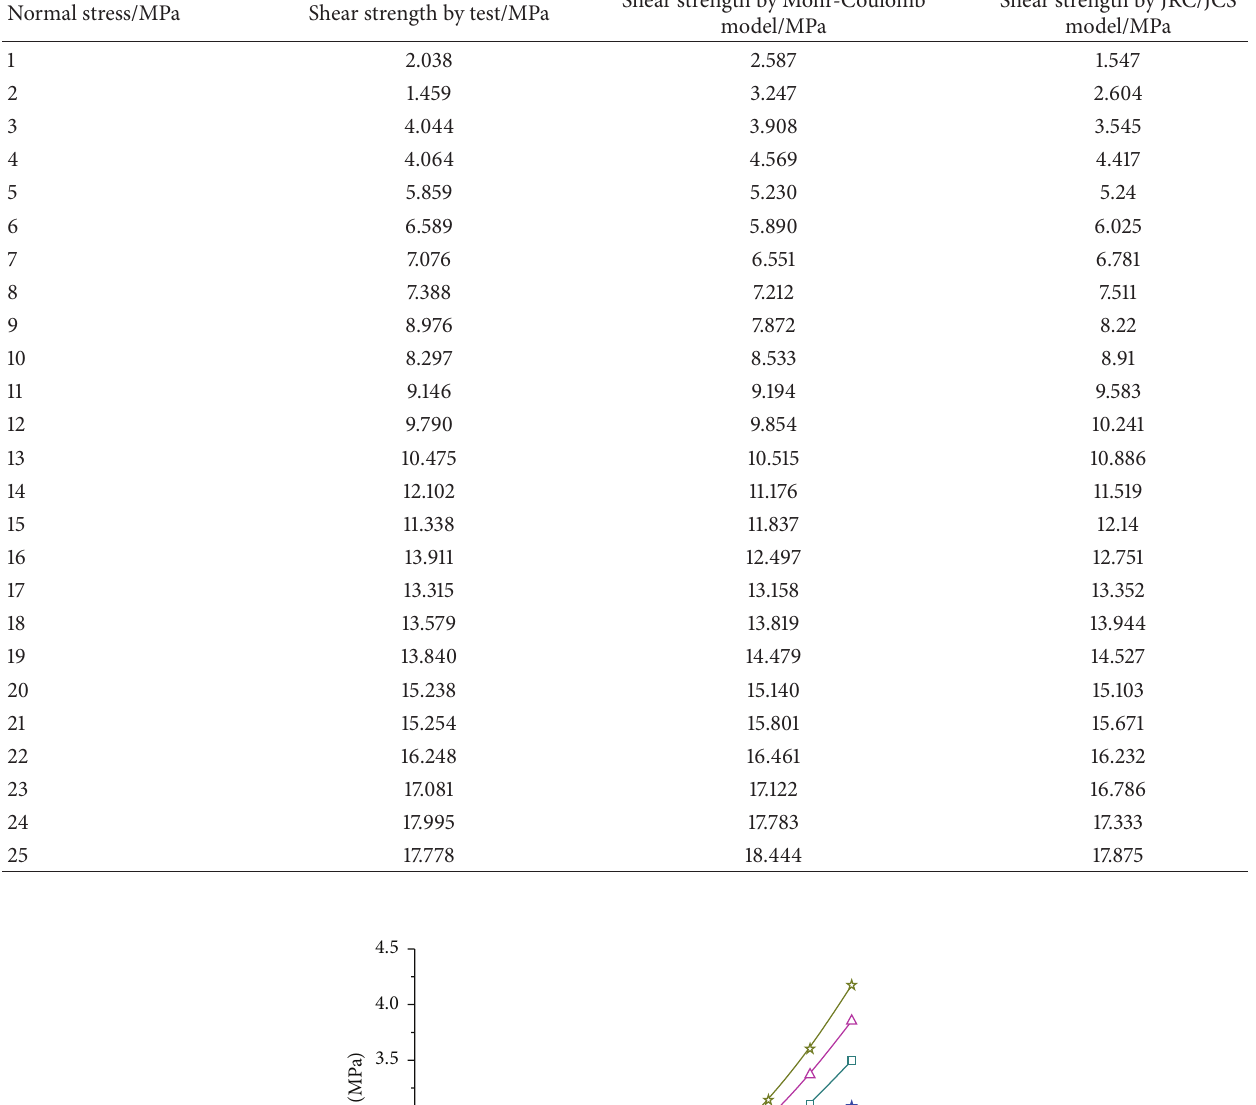
Table 1: Validation of the numerical model.